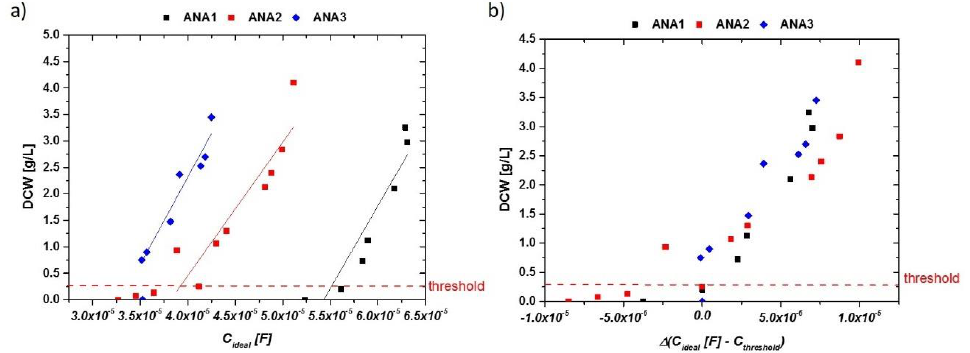
Figure 4. ( a ) Idealized capacitances of anaerobic runs exhibiting sugar concentrations of up to 100 g/L in the fermentation broth (mixture of maltose and glucose). Ethanol concentrations reached 3 vol %. Different absolute values could be found in these cultivations, but the increase of the impedance signal with DCW is very similar. ( b ) DCW vs delta of impedance signal (ideal capacity) in the anaerobic runs. Normalization to the threshold value of about 0.3 g/L resulted in very reproducible signals for very different fermentation runs.